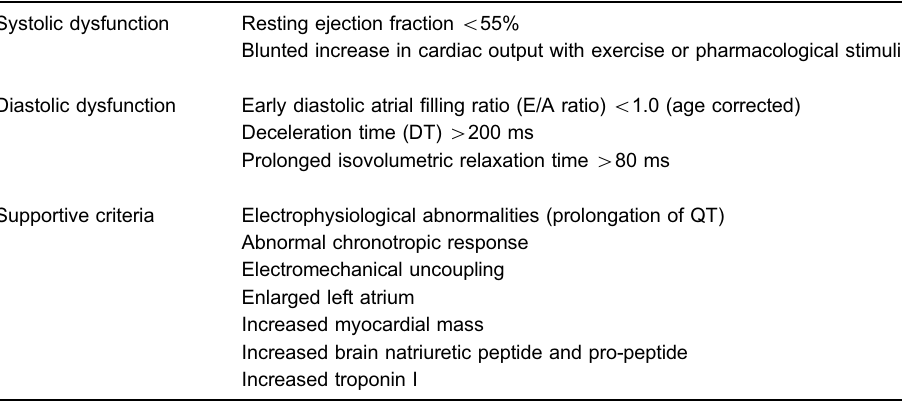
Table 1. Proposal of diagnostic criteria for cirrhotic cardiomyopathy agreed upon at the 2005 World Congress of Gastroenterology in Montreal (10). There are suggestions (not included in this table) to improve these criteria considering dysfunction of right ventricle (15), biventricular diastolic dysfunction at rest, large left and right atria, higher systolic pulmonary arterial pressure and left ventricular mass (16) and evaluate systolic function assessment using tissue strain imaging